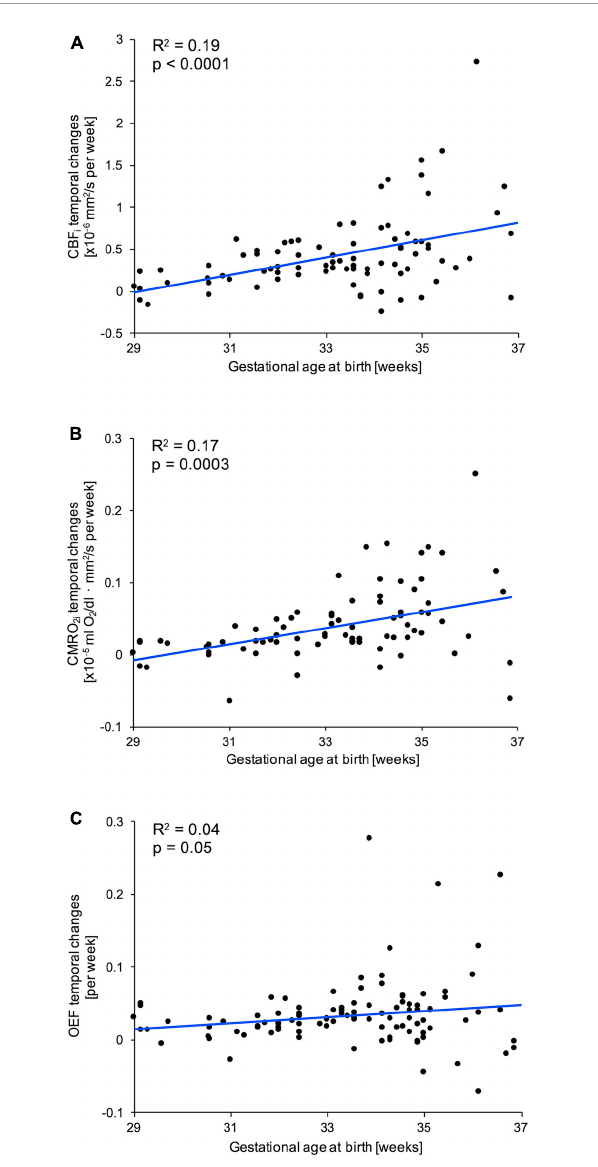
FIGURE2 Associations between temporal changes of (A) cerebral blood flow index (CBF i ), (B) cerebral metabolic rate of oxygen consumption index (CMRO 2 i ), and (C) cerebral oxygen extraction fraction (OEF) with gestational age at birth (GA). For each parameter, a linear fit (blue line) and corresponding correlation coefficient ( R 2 ) and p -value are